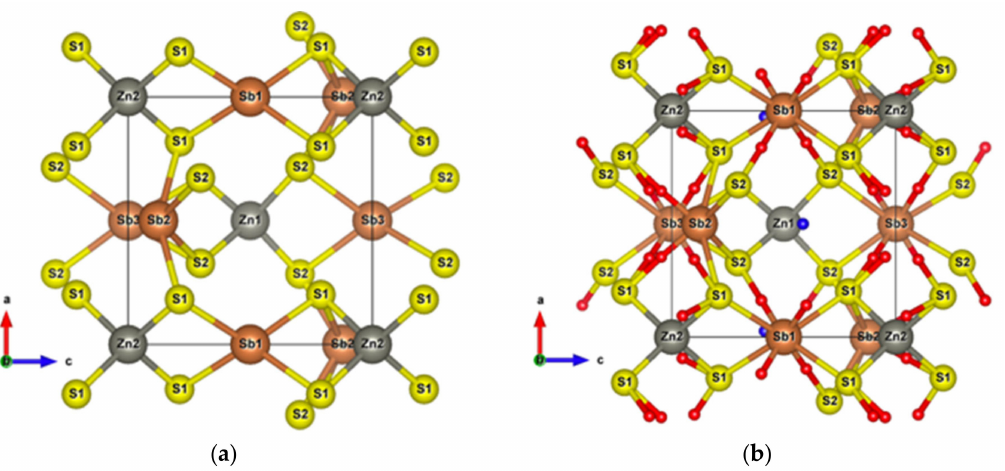
Figure 11. ( a ) Unit cell of SbS 2 Zn 2 ; ( b ) Crystal structure of SbS 2 Zn 2 showing all the weak interactions. Small red balls are BCPs of Sb–S interactions and the blue balls are BCPs of S–S interactions. With two Zn atoms introduced at 1a and 1d Wycko ff positions, under GGA calculations, the band gap decreases from 0.66 to 0.52 eV. Some very localized bands appear in the energy range of − 6 to − 7 eV relative to the Fermi level (Figure S13a). These bands originate from the Zn-3d orbitals and generate a very intense DOS (Figure S13b and inset), indicating that Zn-S bonds are strong and tend to lower energy. The maximum of the highest occupied orbital, which is dominated by Sb1-s and S1-p